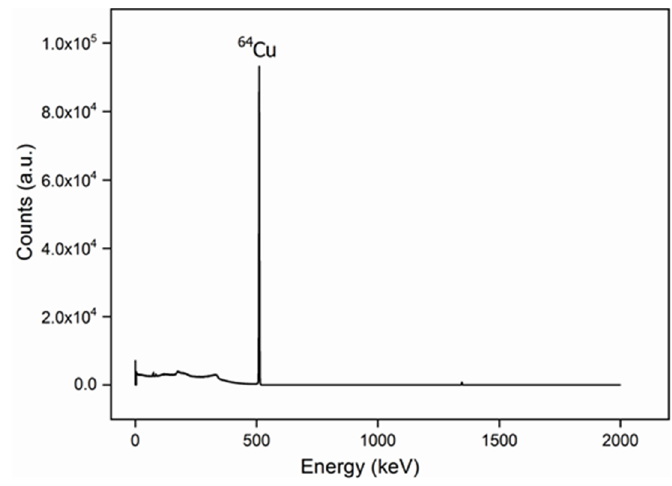
Figure 9. Gamma spectrum of 64 Cu-BNNTs.